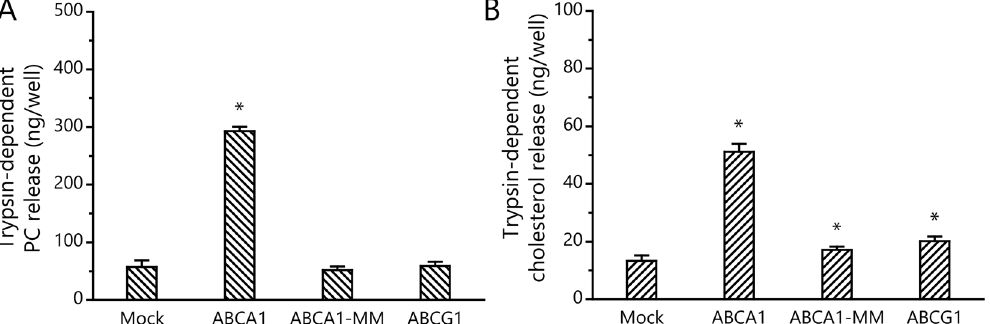
Figure 4. Trypsin-dependent PC and cholesterol release from BHK/ABCA1-MM and BHK/ABCG1. BHK/Mock, BHK/ABCA1, BHK/ABCA1-MM, and BHK/ABCG1 cells were treated with either 0 or 50 μ g/mL of trypsin for 60 min at 37 °C. Amounts of PC and cholesterol released by the trypsin treatment were calculated. Experiments were performed in triplicate, and average values are shown with S.D. * P < 0.01 compared with mock.